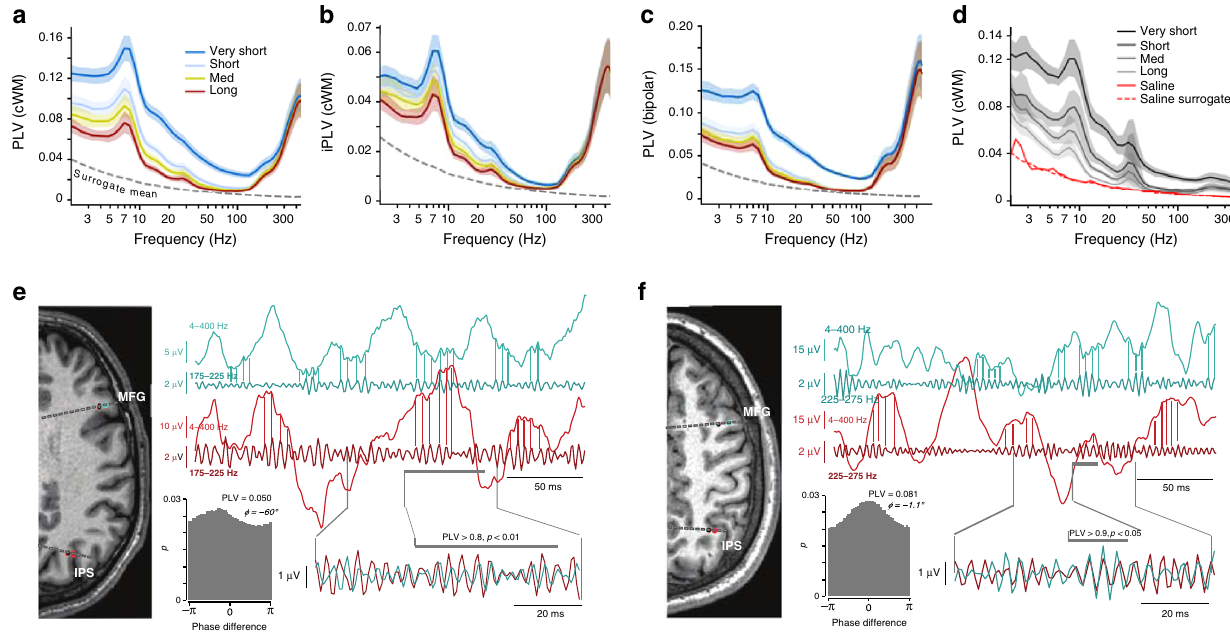
Fig. 2 Long-range synchronization of high-frequency oscillations. a Mean phase synchronization, as measured with the phase-locking value (PLV) and b imaginary PLV (iPLV) between all pairs of cWM-referenced SEEG contacts in distance-range quartiles (92,011 contact pairs in each quartile; very-short: < 32 mm; short: 32 – 45 mm; medium: 45 – 60 mm; long: 60 – 137 mm. Dashed lines are the 99.9th%-ile of surrogate data ( N randomizations = 100). Shaded areas are the 2.5 – 97.5%-ile bootstrap con fi dence-limits of the mean PLV/iPLV ( N bootstraps = 100)). c Mean phase synchronization among bipolar-referenced SEEG contacts. d Phase synchronization between SEEG contacts in saline solution (red lines, synchronization spectra from a are shown in gray for comparison). e Examples of signi fi cant ( p < 0.001) long-range HFO synchronization with non-zero and f near-zero phase lags ( ϕ ) from two subjects (MFG middle frontal gyrus, azure traces and gray-matter contacts in MRI insets, IPS intra-parietal sulcus, red; black circles in MRI insets mark the white-matter reference